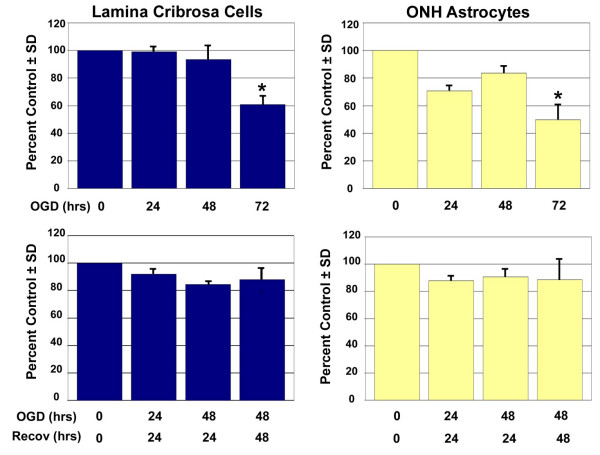
Cell metabolism/cell number following exposure to and recovery from Oxygen-Glucose Deprivation. Lamina cribrosa cells and ONH astrocytes were exposed to oxygen-glucose deprivation (OGD), recovery following OGD or control conditions for the time points indicated. Three LC cell lines and three ONH astrocyte cell lines were assayed per experiment. A standard curve was generated for each cell line in order to calculate cell metabolism/cell number. Data shown as percent of the control and represents the mean ± SEM (n = 3). * indicates p < 0.008 (one way analysis of variance [ANOVA] followed by validation using Student-Newman-Keuls tests).